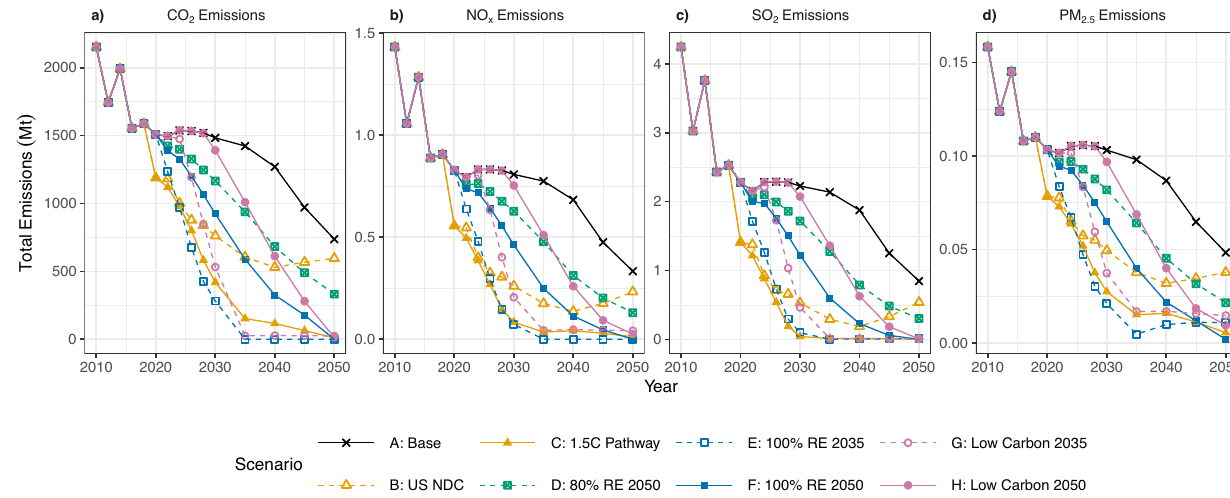
Fig.2|Nationaloperatingemissionsacrossscenarios2010 – 2050(megatonnes, Mt). The emissions shown here are: a CO 2 operating emissions, b NO x operating emissions, c SO 2 operating emissions, and d PM 2.5 operating emissions. Note that the y -axes are not consistent. We see the base case (black line) as an upper bound onallemissionstypesandScenariosC(solidyellowline)andE(dottedblueline)as